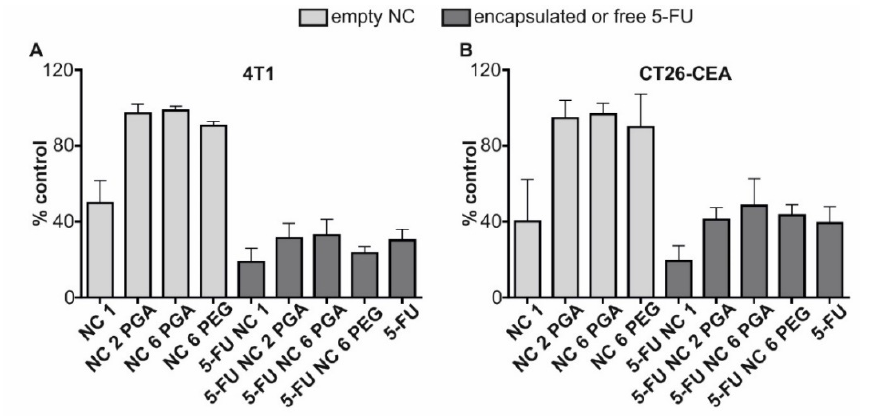
Figure 6. The effect of free and encapsulated 5-fluorouracil on the viability of murine cancer cells 4T1 ( A ) and CT26-CEA ( B ). The cells were incubated 48 h with empty nanocarriers, free or encapsulated 5-fluorouracil. MTT analysis was performed to assess the cell viability. The error bars represent the mean ± SD of at least three independent experiments using nanocarriers derived from three different syntheses.